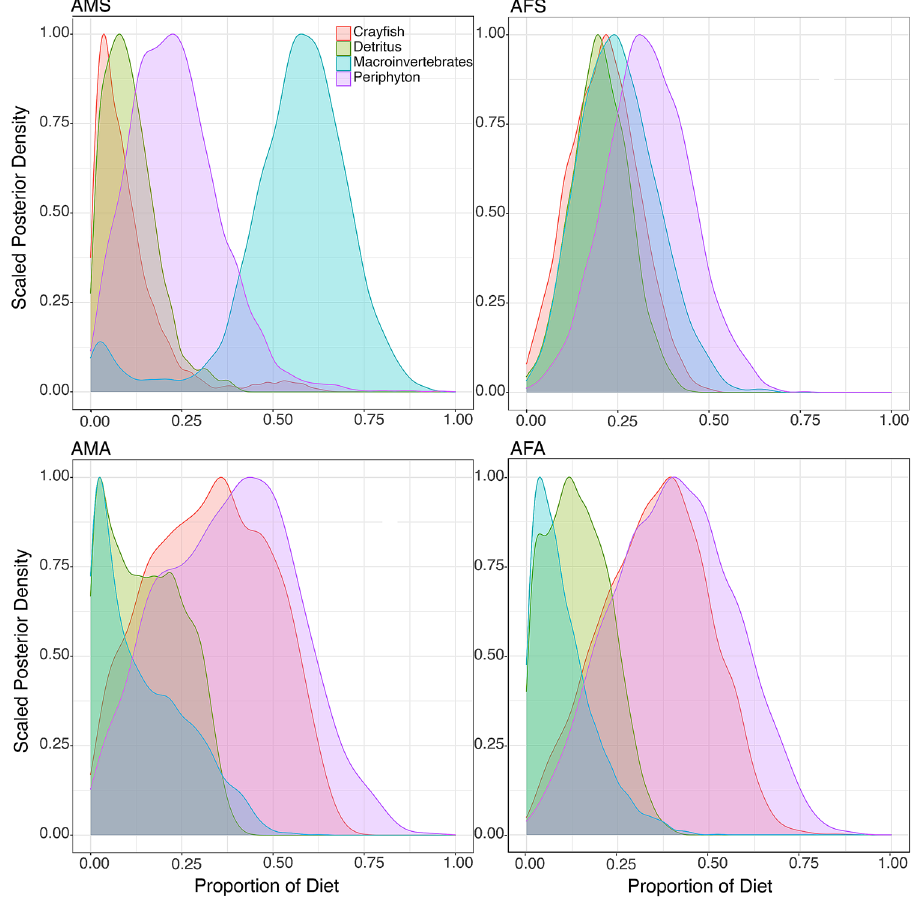
Figure 3. Food source proportions of adult male (AMS) and female (AFS) signal crayfish in summer, and adult male (AMA) and female (AFA) in